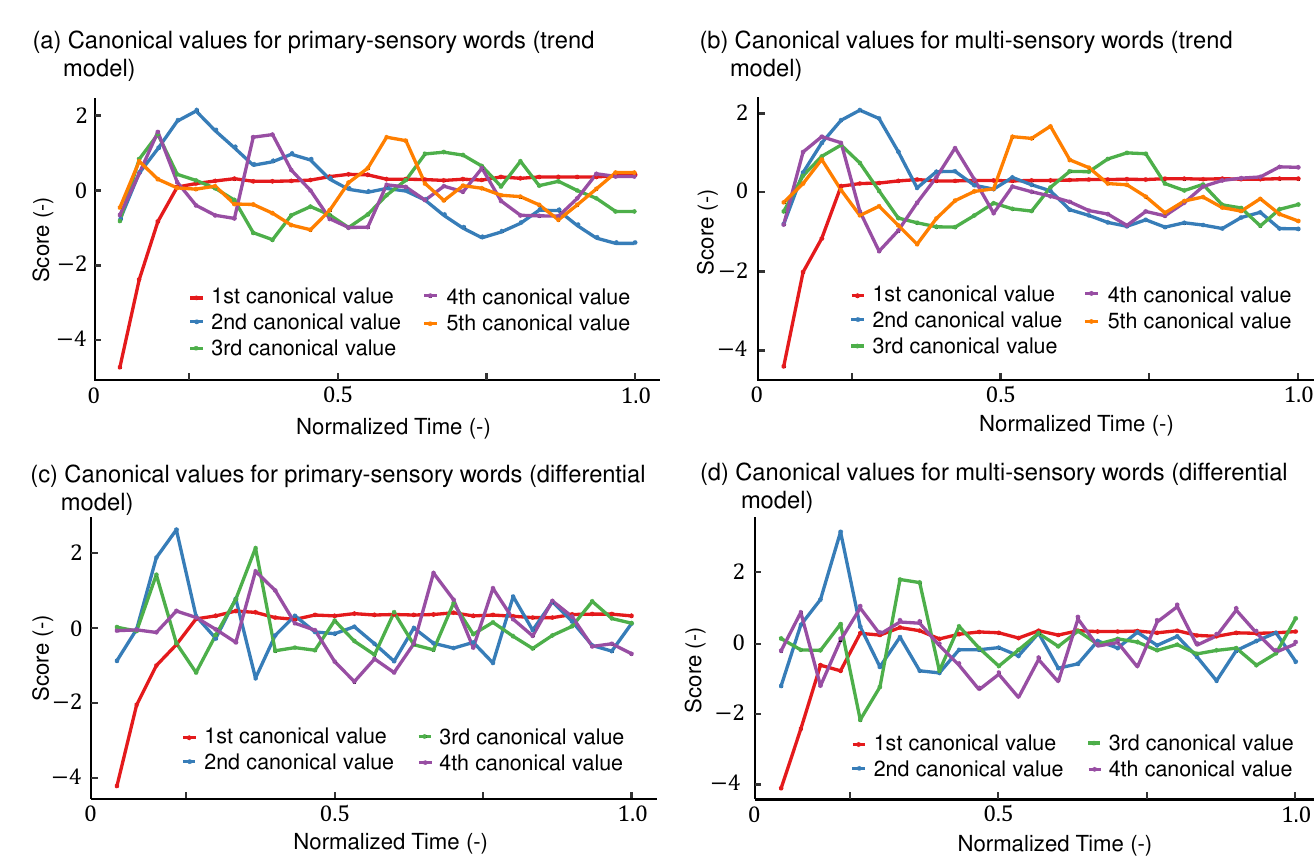
Figure 4. Temporal changes of canonical values corresponding to the primary-sensory ( a , c ) and multi-sensory attribute words ( b , d ). ( a , b ): Canonical values of the trend model. ( c , d ): Canonical values of the differential